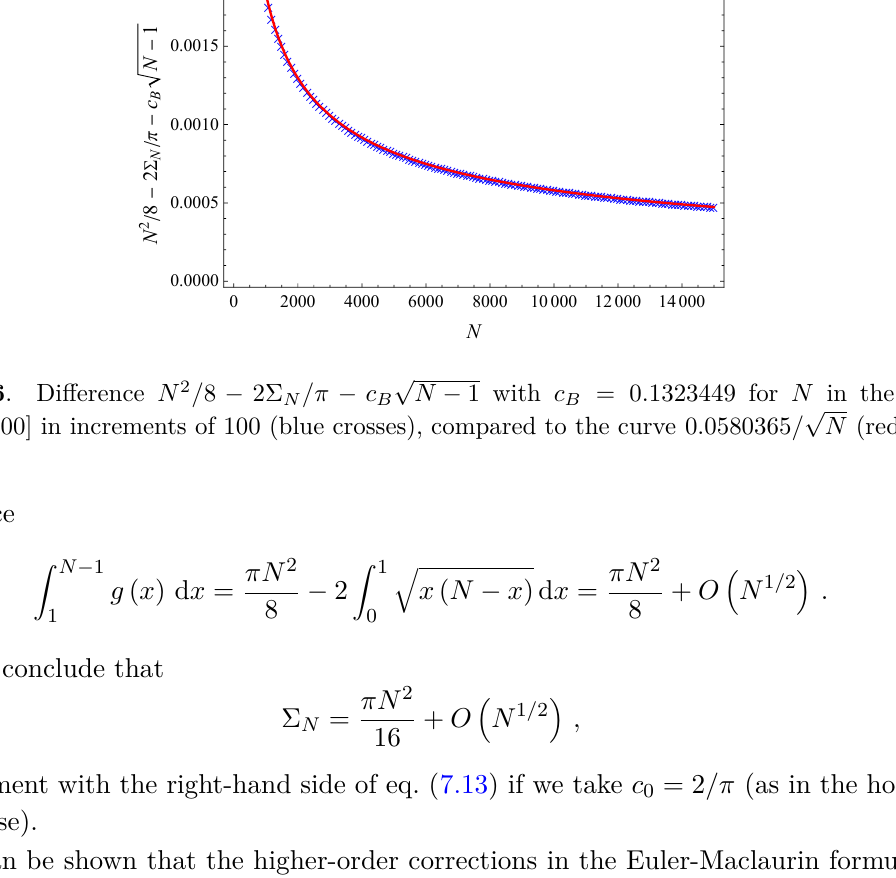
√ N − 1 with c B = 0 . 1323449 for N in the range